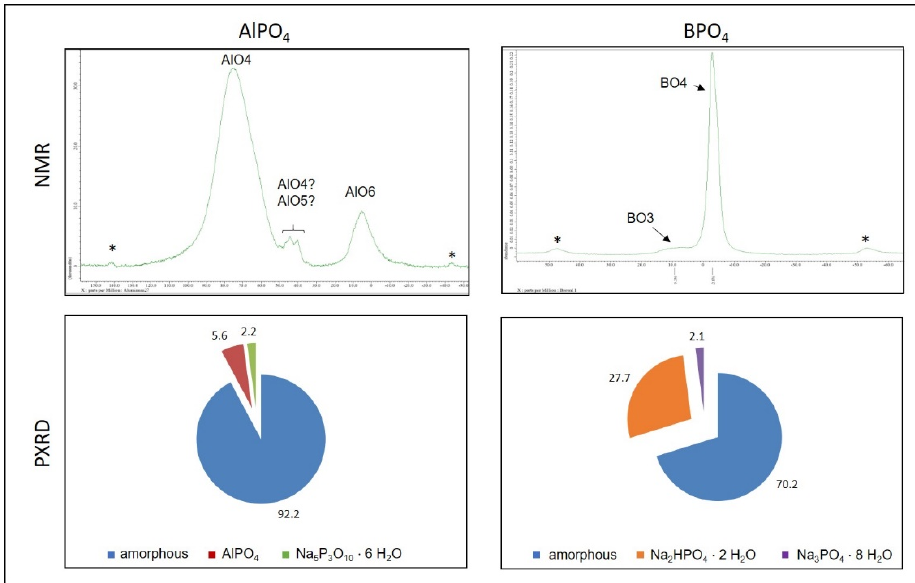
Figure 7. Results of 27 Al and 11 B MAS NMR ( 1st row ) and PXRD ( 2nd row ) measurements of sodium water glass hardened either with AlPO 4 ( 1st column ) or BPO 4 ( 2nd column ) * spinning sidebands